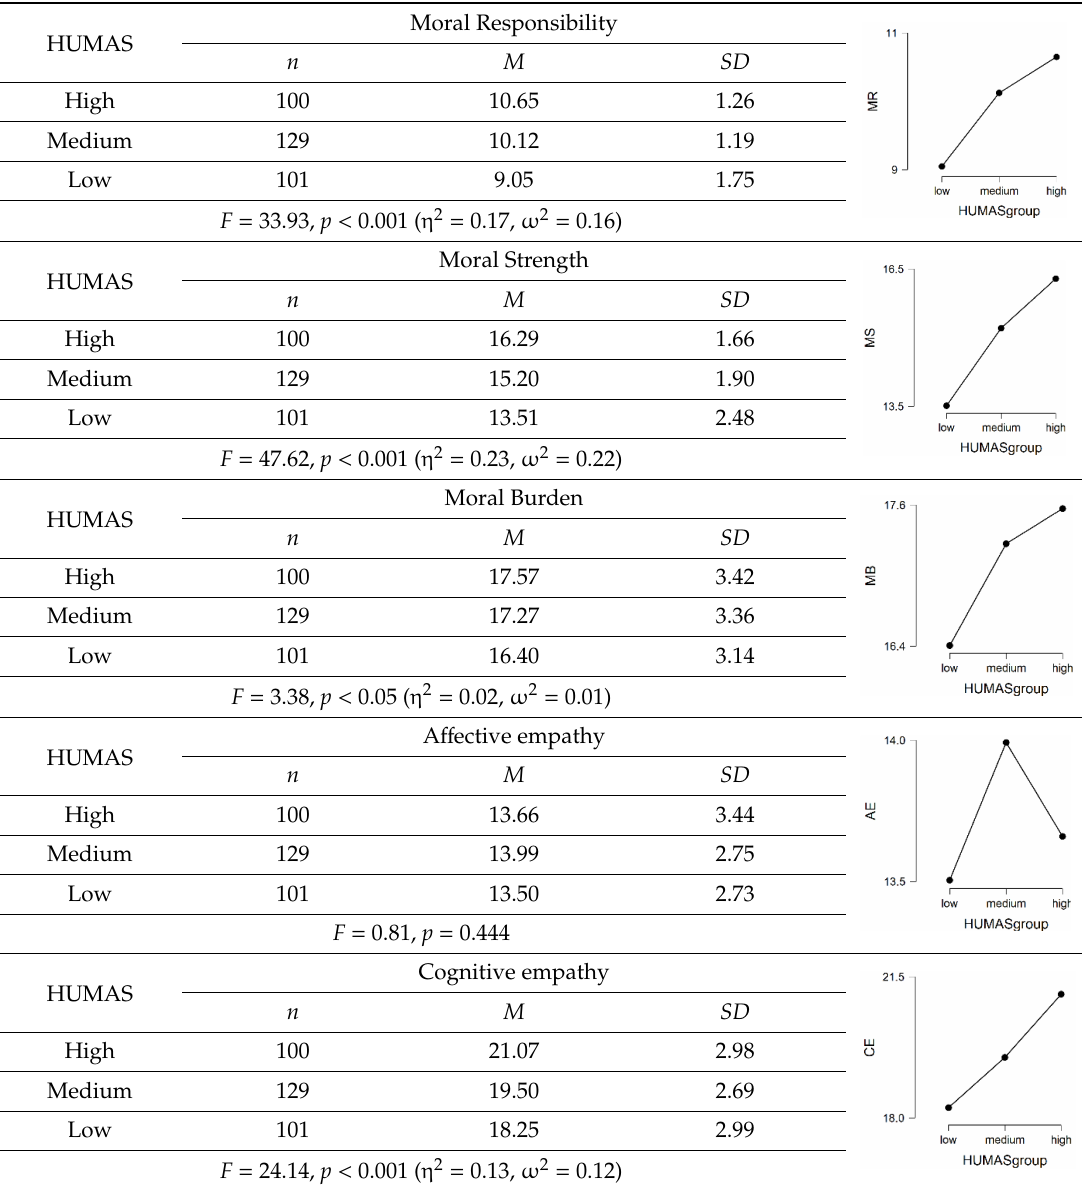
Table 2. Moral sensitivity, empathy and prosocial behavior by HUMAS group. Descriptive statistics and